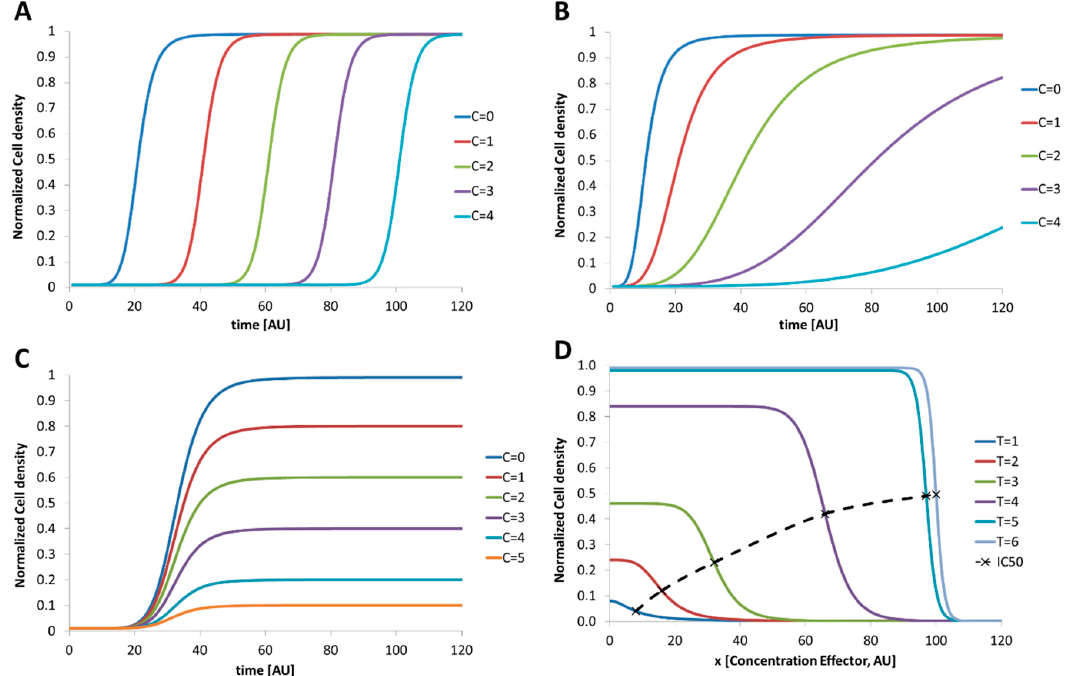
Figure 1. Schematic graphs indicate the development of the cell density over time in dependence on increasing effector concentrations. Examples for the different response types are: ( A ) increasing effector concentration prolongs the lag phase, but do not interfere with the other phases. Here, the organism needs some time to adapt to the changed conditions before the number of organisms starts to grow. Hence, the lag phase is proportional to the effector concentration; ( B ) increasing effector concentration reduces the exponential growth (doubling time). The organism number increase, but the effector reduces the rate of proliferation; ( C ) increasing effector concentration does not influence the lag—or exponential—phase but limits the maximum cell density in the stationary phase. Here, the number of organisms increases up to a limit proportional to the effector concentration. Depending on the chosen detection sensor for the cell density a change in morphology (organism may form aggregates or shrink as response to the effector) can cause this effect; ( D ) dose–response plot indicates the development of the cell density over the effector concentration for different times. It represents the data which are gained by experiments to derive the growth kinetics as shown before. Characteristic point is the inhibitory concentration which indicates the effector concentration that inhibits the growth by 50% of the maximum cell density without effector (IC50-Value). Dashed line indicates the temporal development of the IC50 values which would be determined at the different points in time.